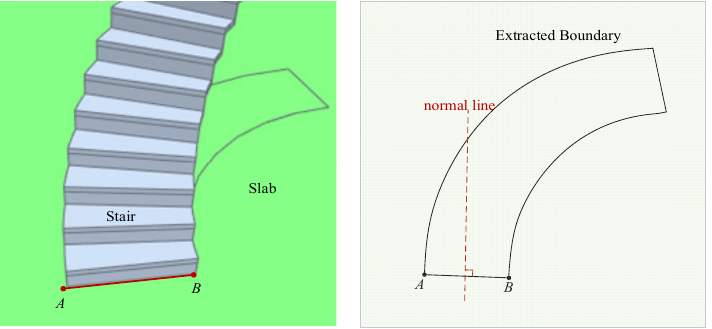
Figure 9. Illustration of selecting start line and the path direction for the X-Z topological path. To select the correct path direction, this study makes a normal line for the start line AB